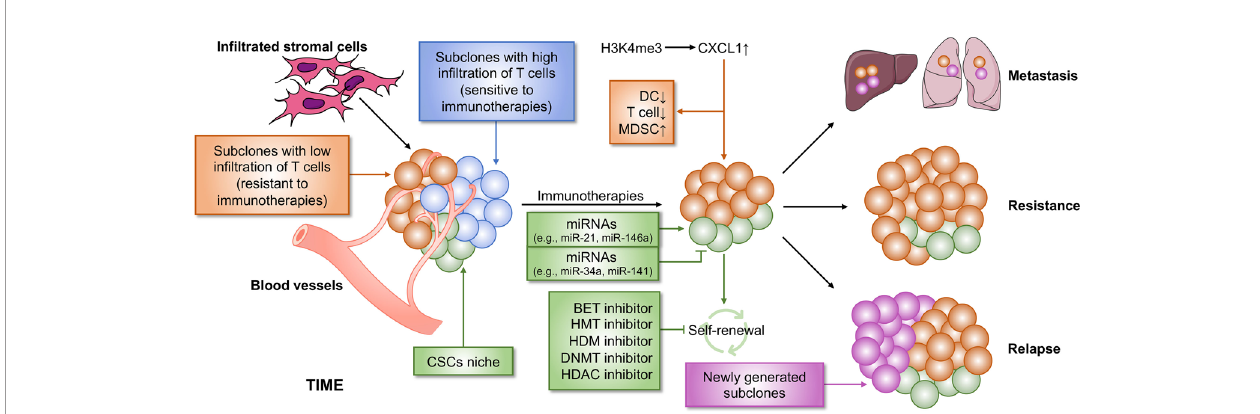
FIGURE 3 | Epigenetic regulation of ITH that contributes to immunotherapy resistance. Cancer is a heterogeneous disease with a complicated TIME, leading to immunotherapy failure. Two main reasons contribute to immunotherapy resistance. First, within the TIME, there are some subpopulations of tumor that are non- responsive to immunotherapy, which causes resistance to immunotherapy. Second, CSCs cause poor clinical outcome in immunotherapy. CSCs may be not completely eliminated by immunotherapy, which subsequently lead to tumor relapse and metastasis. Both the two processes can be regulated by epigenetics, suggesting that a combination of immunotherapy and epi-drugs may be an effective strategy for cancer therapy. BET, bromodomain and extra-terminal domain; HMT, histone methyltransferase; HDM, histone demethylase; DNMT, DNA methyltransferase; HDAC, histone